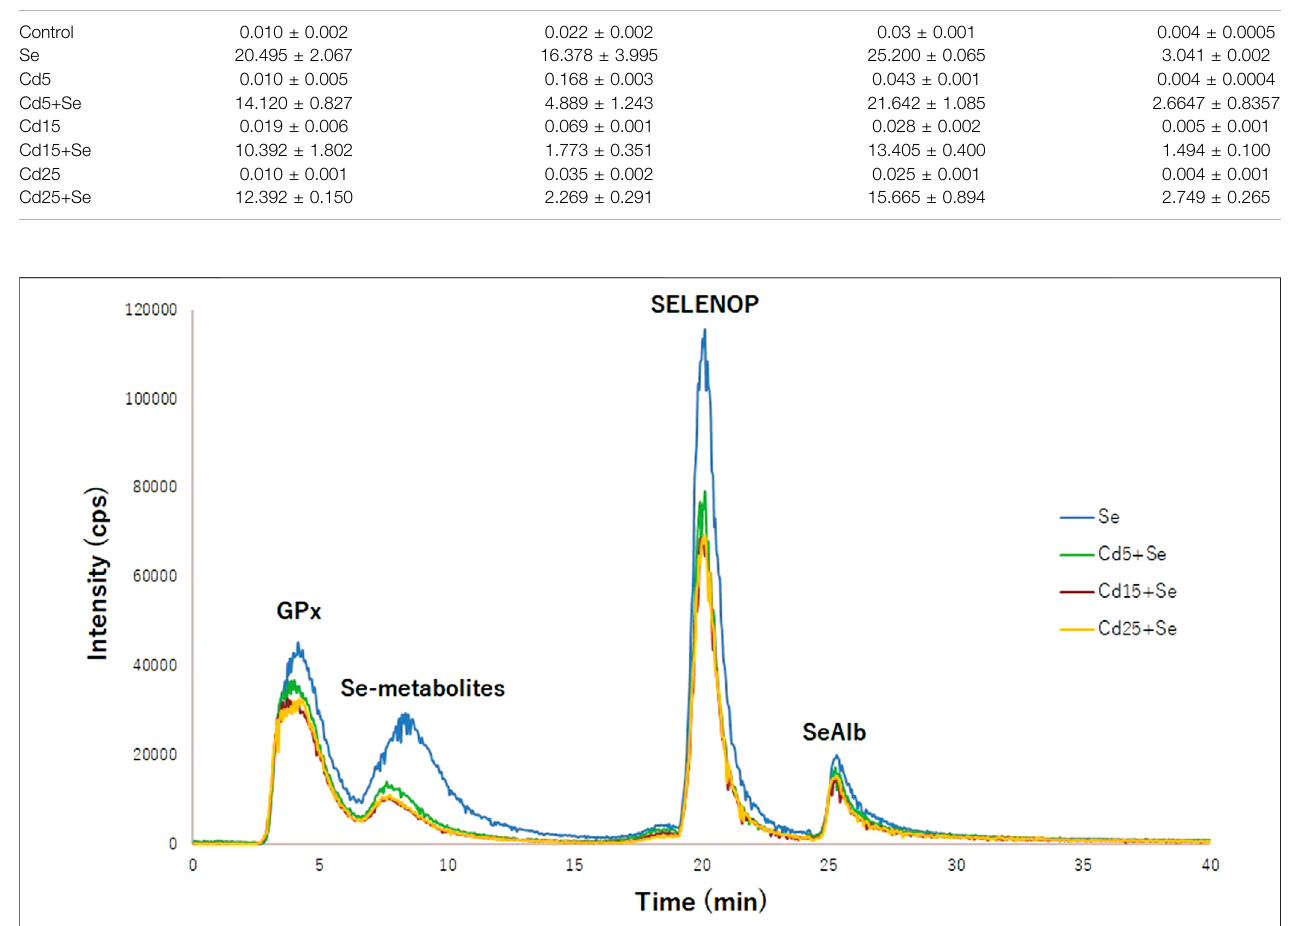
Frontiers in Chemistry |